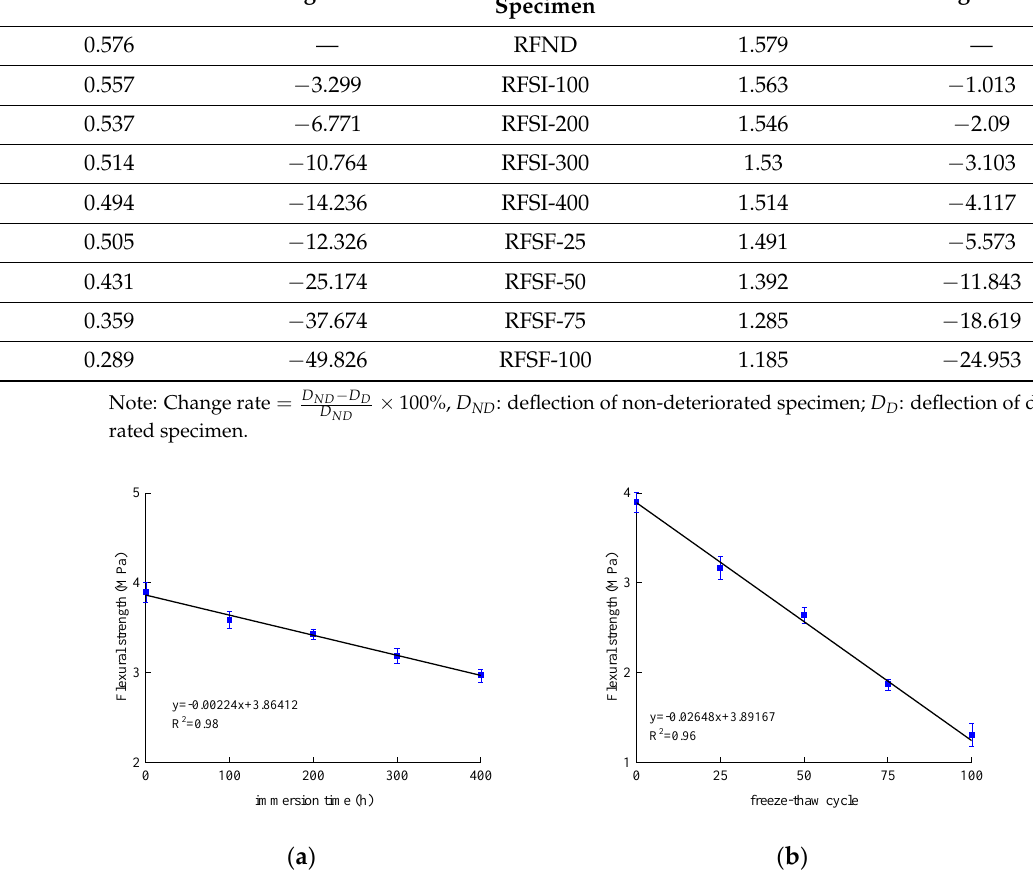
( b ) Figure 28. Flexural strength of reinforced concrete specimen: ( a ) chlorine salt immersion environ- ment; and ( b ) salt-freeze coupled environment.